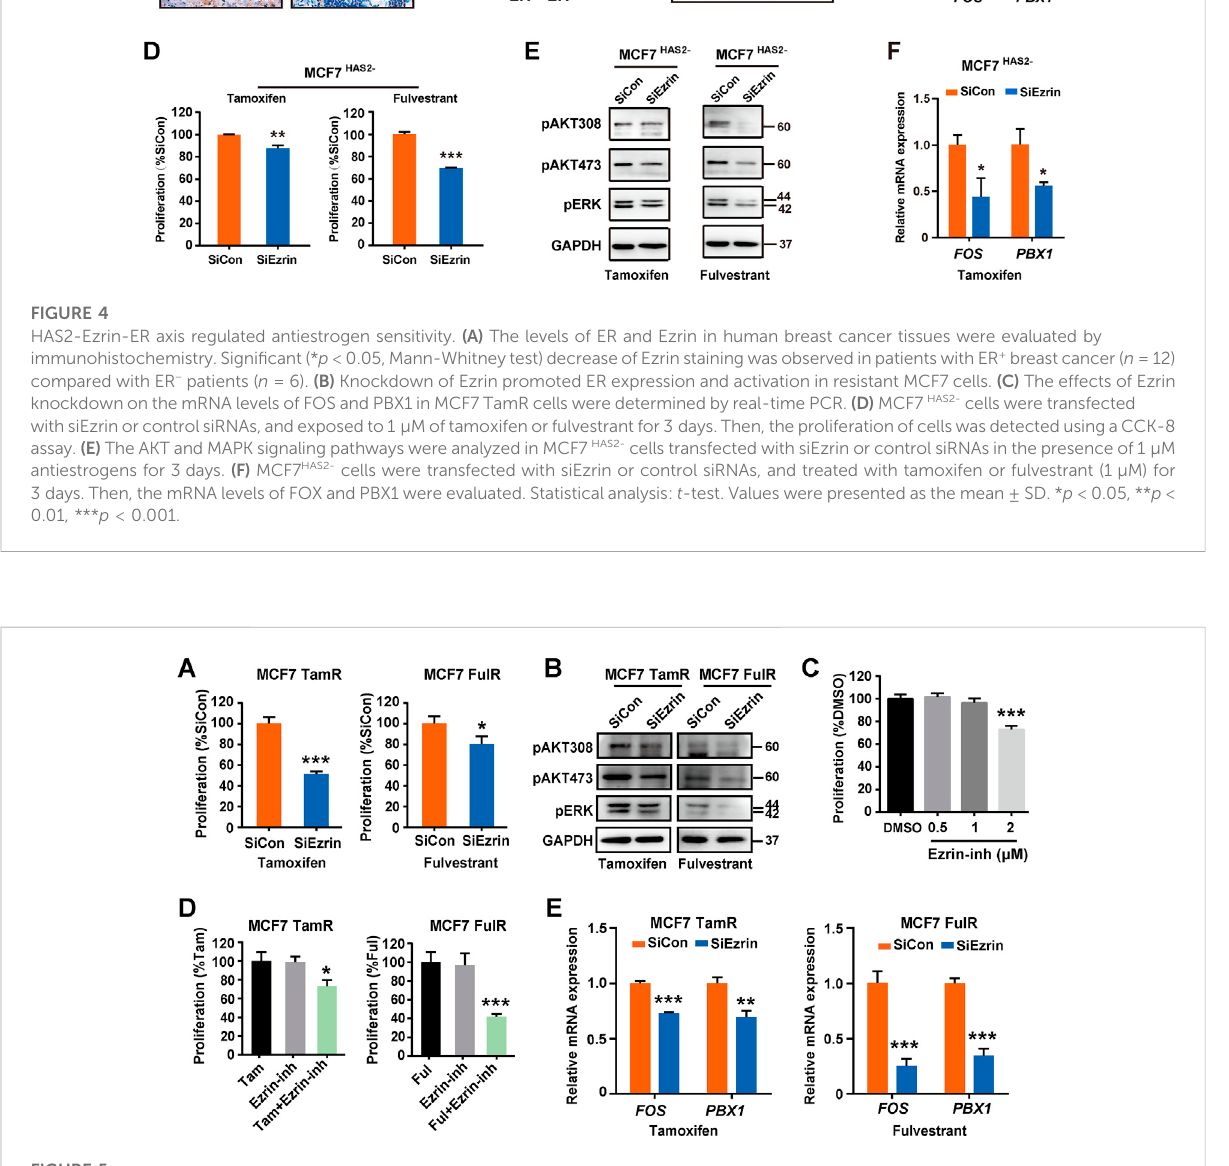
FIGURE 5 Inhibition of Ezrin restored the sensitivity of ER + BrCa cells to antiestrogens. (A) The changes of cell sensitivity to tamoxifen or fulvestrant in resistant MCF7 cells with Ezrin knockdown were determined by a CCK-8 assay. (B) Resistant MCF7 cells were transfected with siEzrin or control siRNAs.Then,thechangesofcellsurvivalsignaling inthepresenceoftamoxifenorfulvestrantweredeterminedbyimmunoblotting. (C) Theeffectof Ezrin inhibitor (Ezrin-inh) at different concentrations on the proliferation of naïve MCF7 cells. (D) The in fl uence of Ezrin inhibitor on the sensitivity of resistant MCF7 cells to tamoxifen or fulvestrant was determined using a CCK-8 assay. (E) Resistant MCF7 cells were transfected with siEzrin or control siRNAs, and treated with tamoxifen or fulvestrant (1 μ M) for 3 days. Then, the mRNA levels of FOX and PBX1 were evaluated. Statistical analysis: t -test. Values were presented as the mean ± SD. * p < 0.05, ** p < 0.01, *** p <